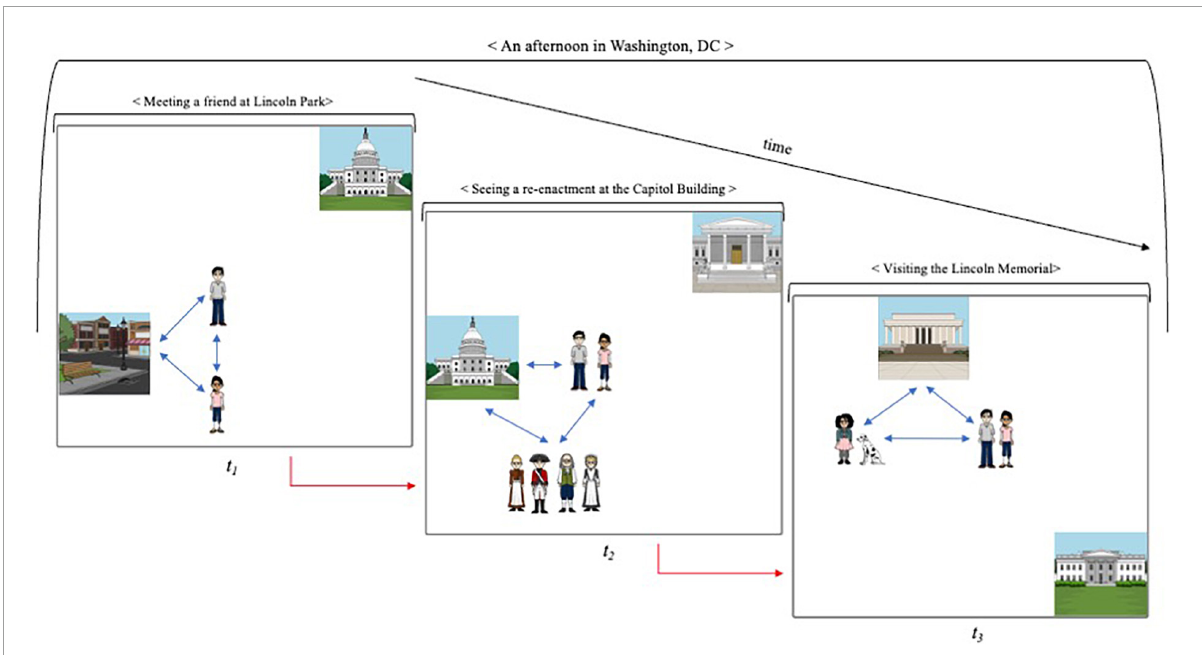
FIGURE2 Running a kinematic model of a complex episode. The model simulates the changing states in an episode, re-enacting its spatiotemporal dynamics. As the model “unfolds,” the reconstructed context provides cues for the retrieval of elements associatively bound to it. The blue arrows represent binding of items and locations in a given (sub-)event. The red arrows represent sequential binding of elements in the event sequence.